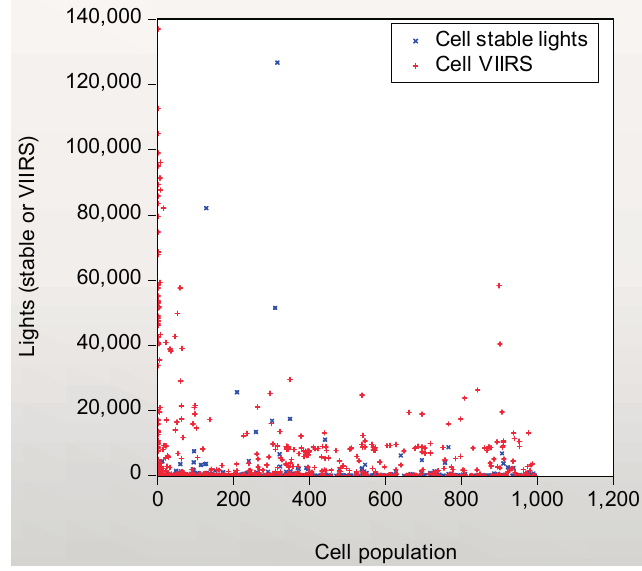
Figure 1. Scatter plot of cell population, stable lights, and Visible Infrared Imaging Radiometer Suite (VIIRS) lights for cells with a population <